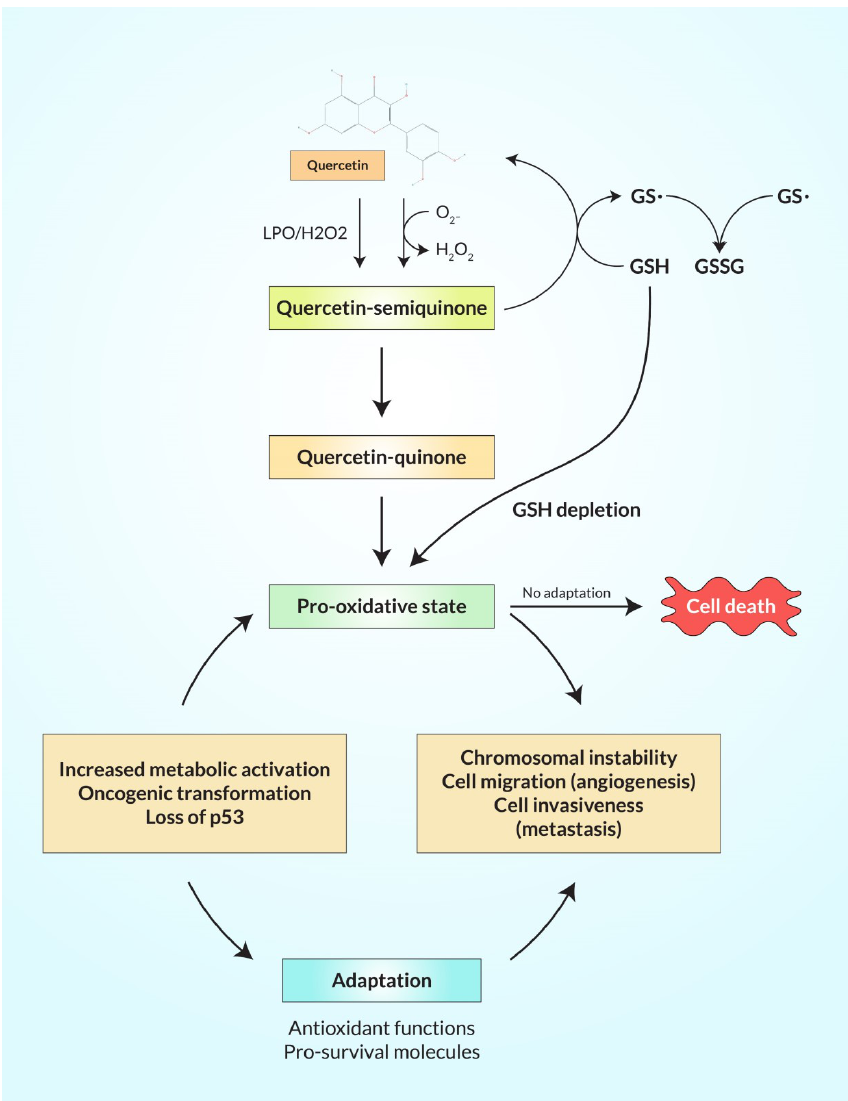
Figure 6. Diagrammatic pathway related to the effects of QC as both antioxidant, and pro-antioxidant in the presence of low and high levels of reduced GSH, both effects are strongly dependent upon the reduced GSH enzyme. During oxidative stress, in the presence of peroxidase, QC reacts with H2O2 to form a semiquinone radical that is rapidly oxidized to QQ, has a pro-oxidant effect, high reactivity towards protein thiols, and DNA leads to cell damage, and cytotoxicity. QQ preferentially reacts with GSH to stable protein oxidized QC adducts namely 6-GSQ, and 8-GSQ. In the presence of high GSH concentration, QQ reacts with GSH to form GSQ, and QQ cannot exert its cytotoxic effects, by contrast QQ reacts with protein thiols, and leading to cellular damage in the depletion of the GSH enzyme level.